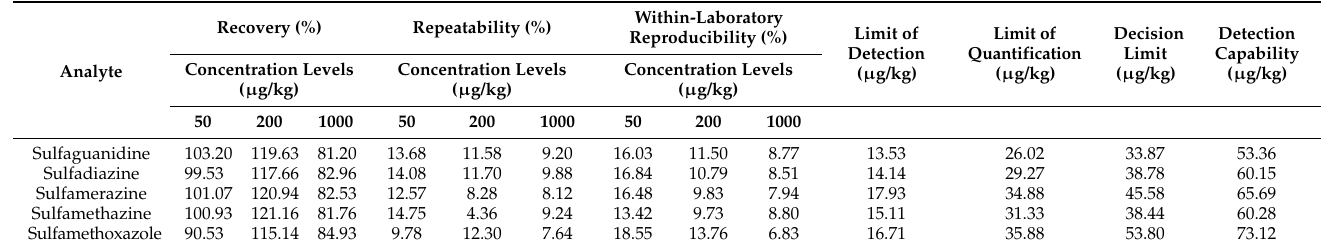
Table 1. Validation results for liquid manure and digestate.